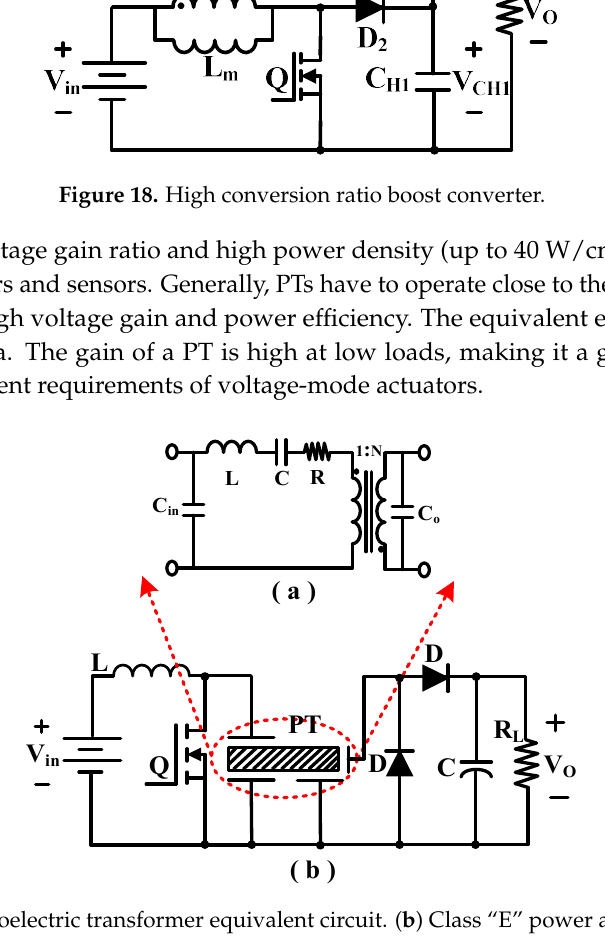
Table 3. Comparison of the main parameters of the five described topologies.